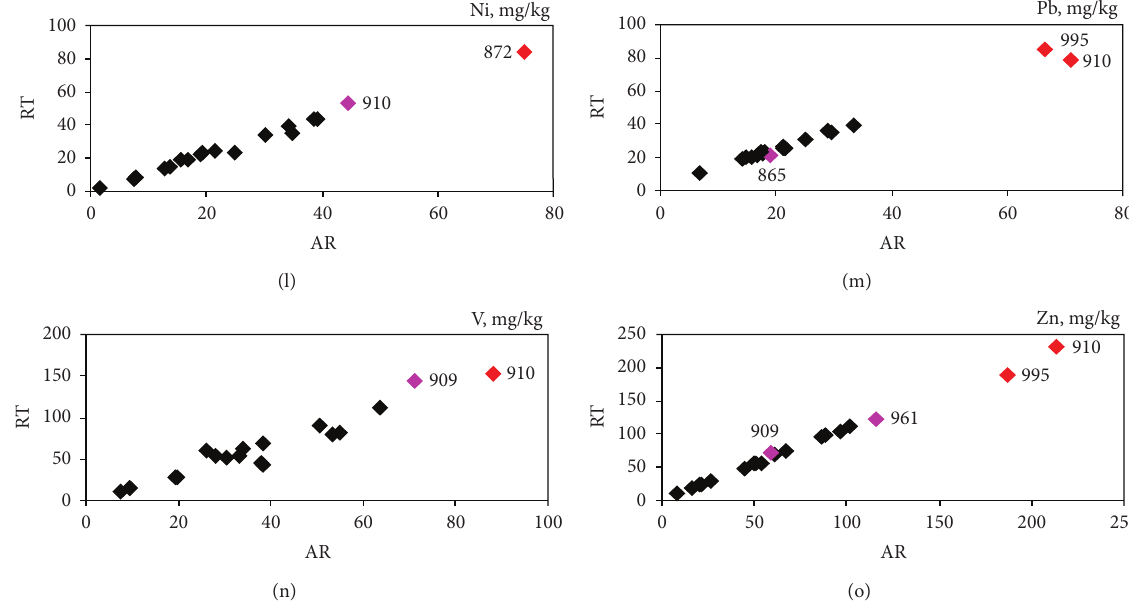
F 3: Scatterplots of aqua regia versus real total contents of more reliably characterised harmful chemical elements. Explanation is given in Figure